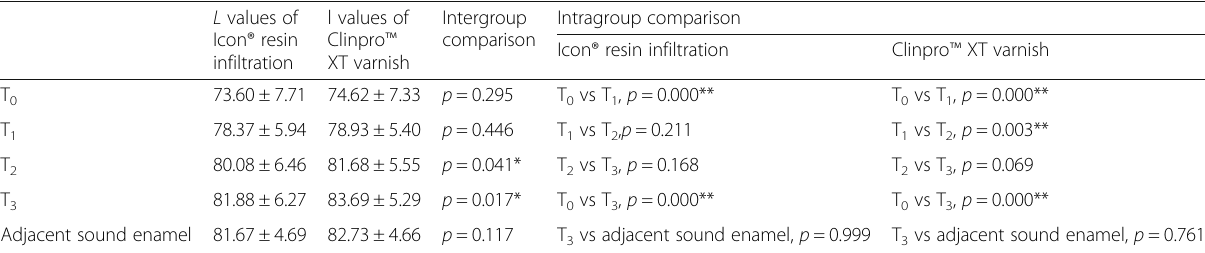
Table 2 Intergroup and intragroup comparison of lightness values at various time